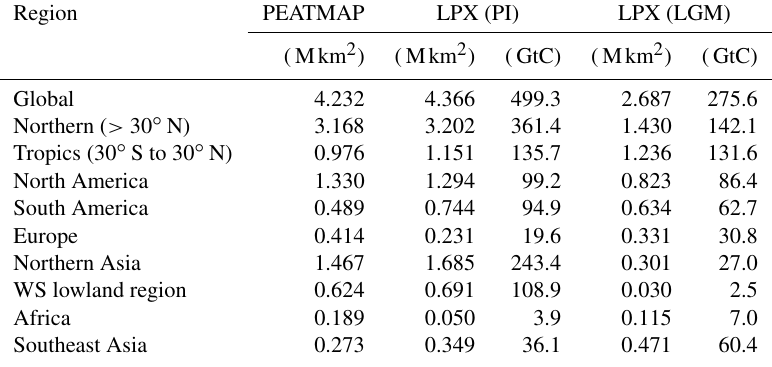
Table 1. Peatland area for different regions and latitudinal bands as given by PEATMAP (Xu et al., 2018) for today and peatland area and their carbon stocks as simulated by LPX-Bern for the preindustrial (PI) period and the Last Glacial Maximum (LGM) in the transient “standard” setup simulation from 22kyrBP to present. The extent of the northern Asia, western Siberian (WS) lowland, and Southeast Asia regions are shown in Fig.